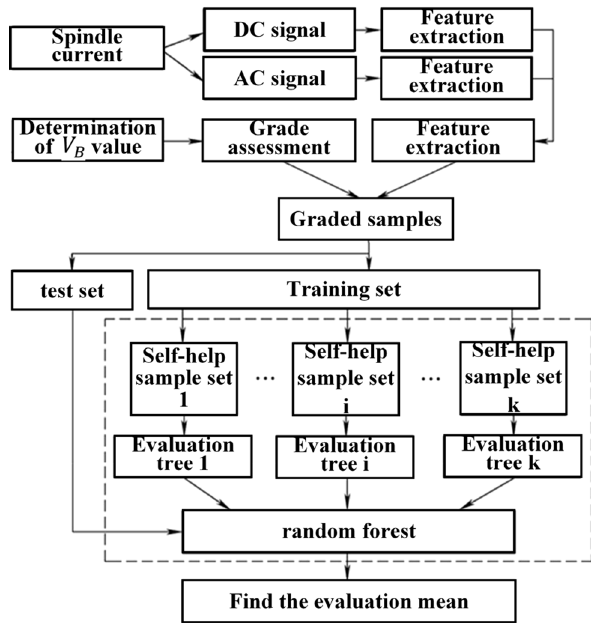
Fig. 9 Random forest estimator structure